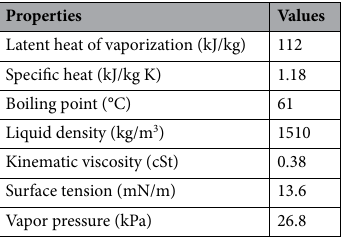
Table 1. Major thermos-physical properties of HFE-7100 (1 atm., 25